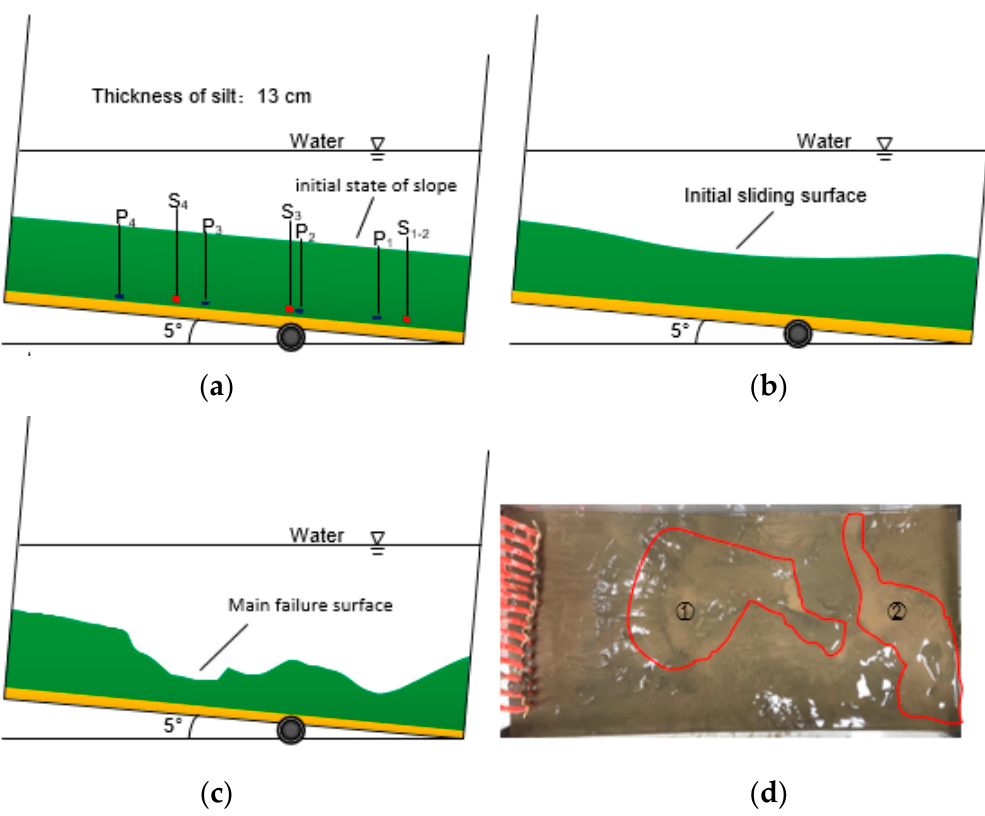
Figure 10. Profile and plan views of the slope after failure in Model 13-5. ( a ) Before Angle adjustment; ( b ) After the Angle adjustment; ( c ) After the destruction; ( d ) top view of end of experiment.